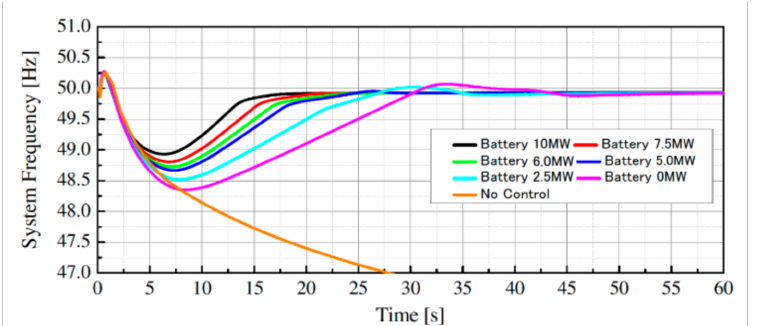
Figure 22. System frequency (II) (Pumping Operation).